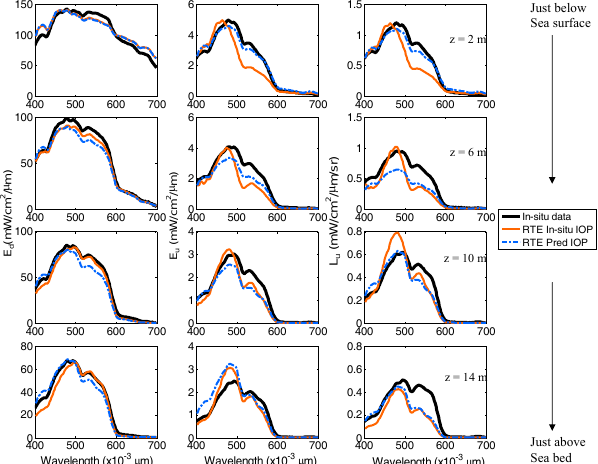
Figure 11. Spectral comparisons of the simulated and measured underwater light fields ( E d , E u and L u ) for four discrete depths in clear waters off Chennai (St-1). The black colour represents the measured data, orange colour represents results from the present RT model using in situ IOP data and the blue colour represents re- sults from the present RT model using the predicted IOPs from the remote-sensing reflectance